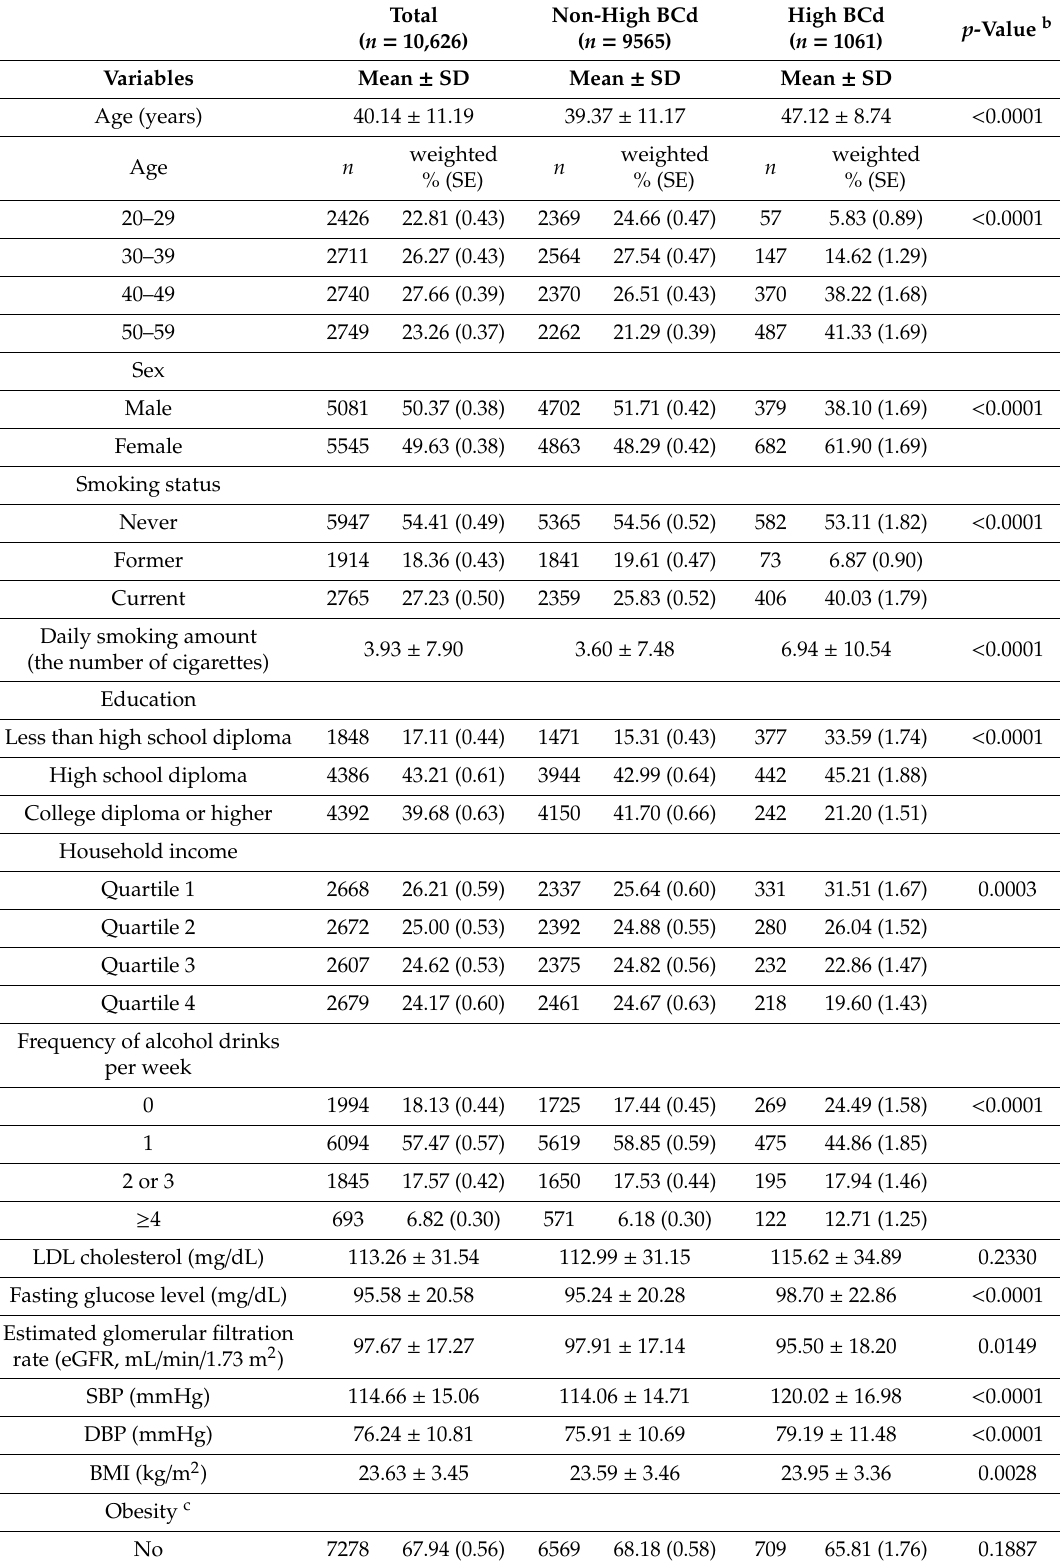
Table 1. General participant characteristics according to blood cadmium (BCd) level